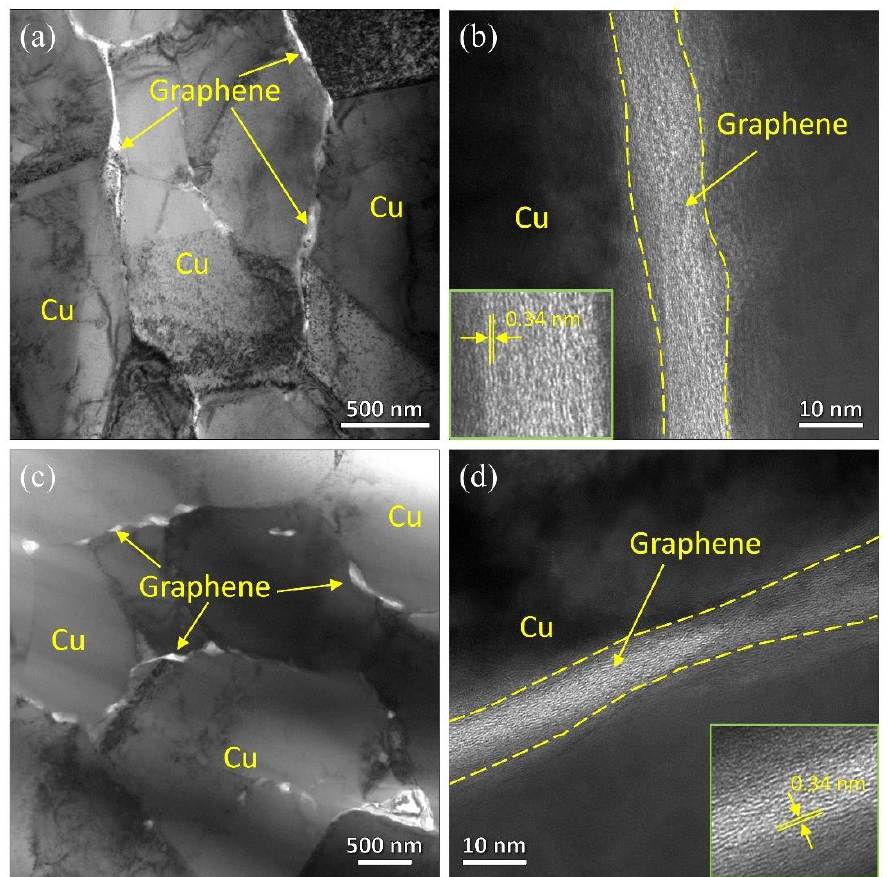
Figure 4. TEM images of the ( a ) as-sintered and ( c ) as-extruded composites, HRTEM images of the ( b ) as-sintered and ( d ) as-extruded composites.